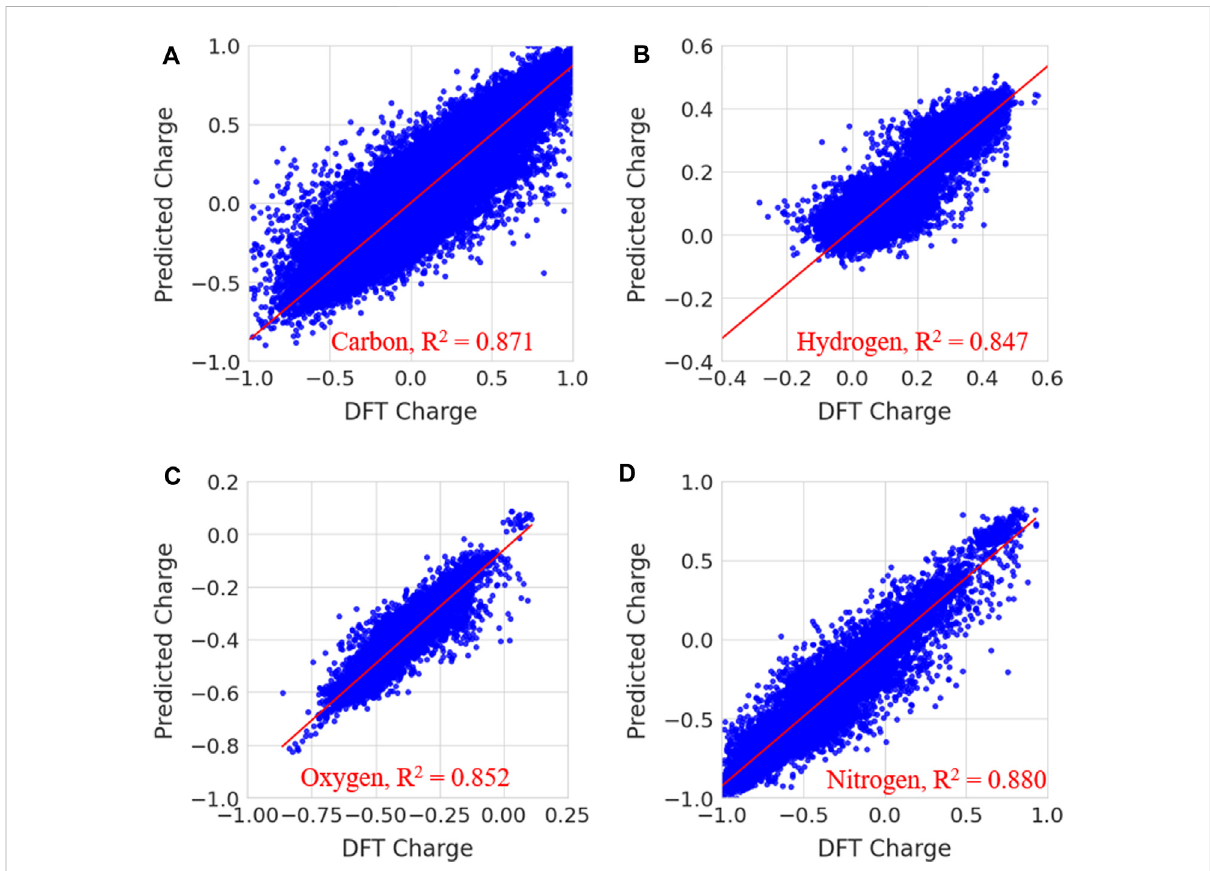
FIGURE 7 Predictionofpartialchargesfor (A) carbon (B) hydrogen, (C) oxygenand (D) nitrogenatomsinthetestdatasetusingarandomforestregression